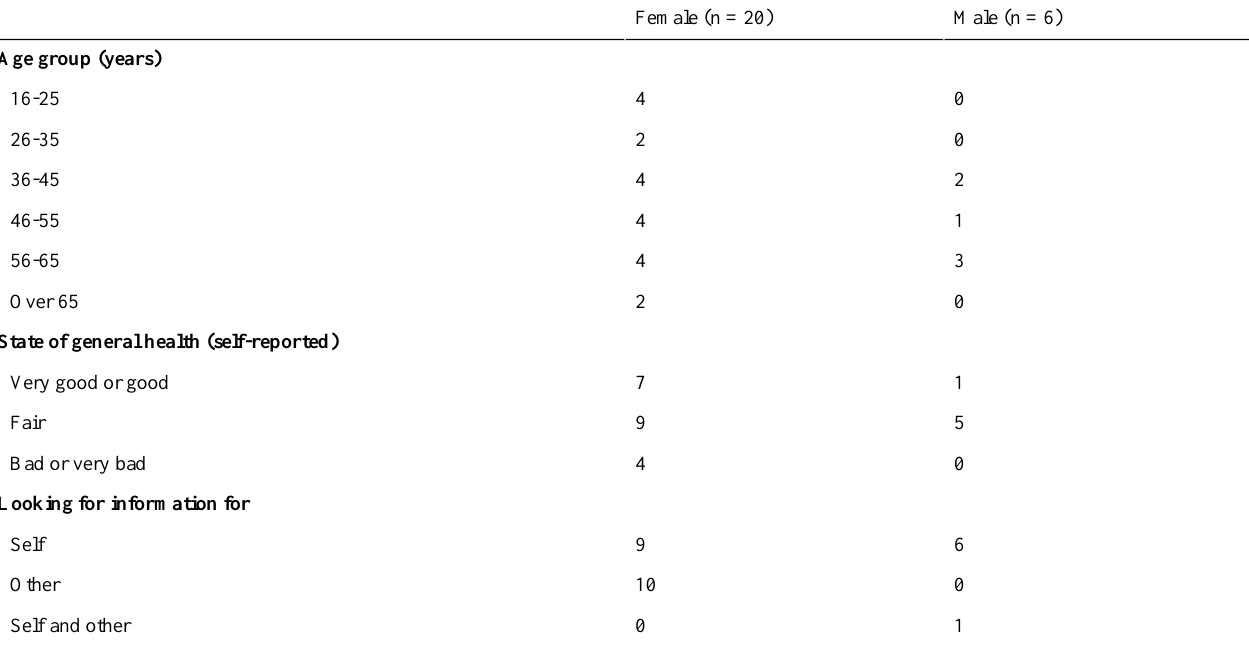
Table 3. Characteristics of interview participants (n =